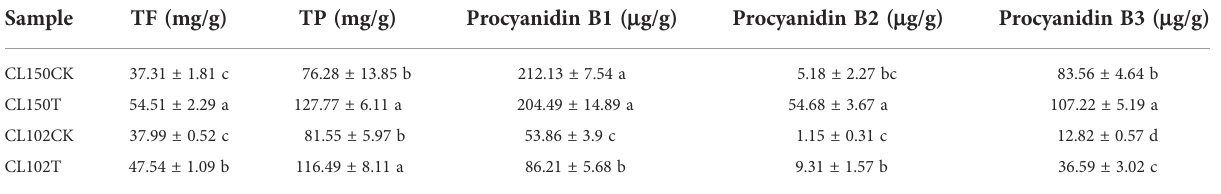
TABLE 1 Flavonoid content of different treatments.